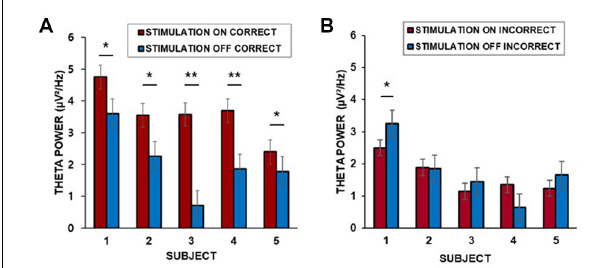
FIGURE 4 | (A) Individual differences in theta power in the middle temporal cortex over 4 s for correctly remembered words during the “on” and “off” periods. (B) Individual differences in theta power in the middle temporal cortex over 4 s for incorrectly remembered words during the “on” and “off” periods. ∗∗ p < 0.01, ∗ p < 0.05, corrected. Error bars indicate the standard error of the mean (SEM).